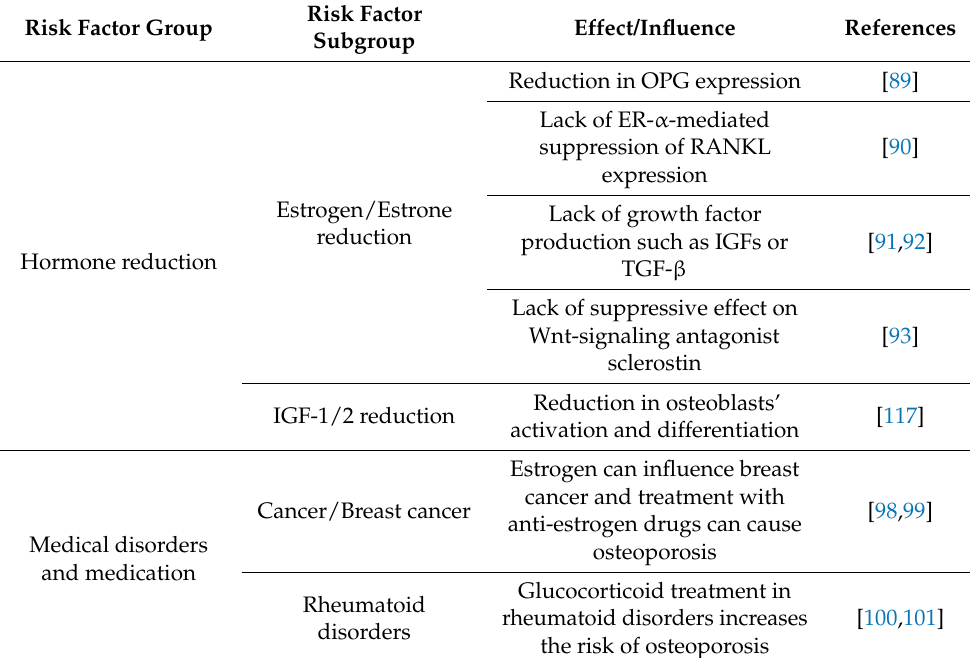
Table 1. Risk factors for osteoporosis. Risk factors can be separated into multiple groups. The first risk factor group is the age-related loss of sex steroids and hormonal changes, while another group of risk factors include environmental and other external factors. All groups were separated into subgroups to depict which factors increase the risk of osteoporosis and